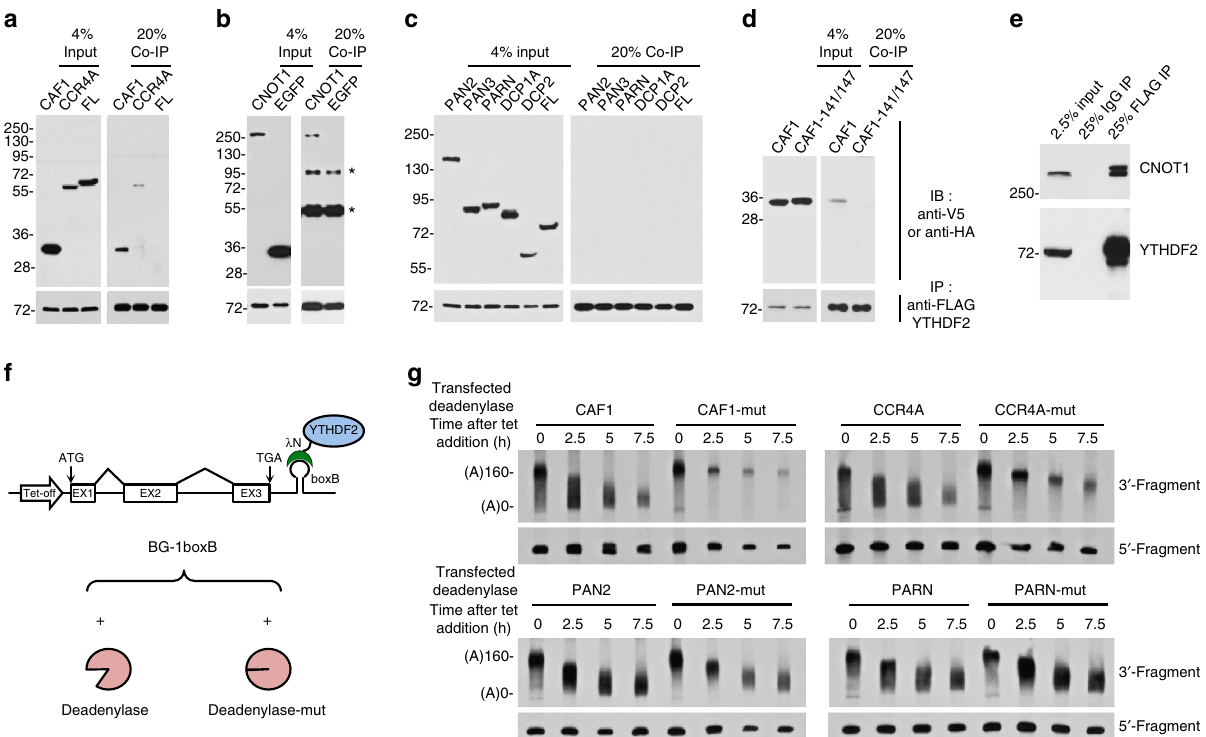
Figure 3 | The CCR4–NOTcomplex is responsible for YTHDF2-mediated RNA deadenylation. ( a – c ) Interaction between YTHDF2 and deadenylases or decapping enzymes. HEK 293 cells were co-transfected with a plasmid encoding FLAG-tagged YTHDF2 and either a V5-tagged CAF1, CCR4A, PAN2, PAN3, PARN, DCP1A, DCP2, FL or an HA-tagged CNOT1 or enhanced green fluorescent protein (EGFP). Lysates were subjected to immunoprecipitation by using anti-FLAG affinity gel. Input and co-purified proteins were blotted by probing with corresponding antibodies. Nonspecific bands were indicated by the asterisk. ( d ) Interaction between YTHDF2 and CAF1 or CAF1-141/147, a mutant version of CAF1 with M141K and L147K double substitution. ( e ) Interaction between stably expressed FLAG-tagged YTHDF2 and endogenous CNOT1 in HeLa-tTA cells. ( f ) Strategy of screening of functional deadenylases that are responsible for YTHDF2-mediated deadenylation. BG-1boxB reporter was co-transfected with l N-FLAG-YTHDF2 and either a wild-type or catalytically inactive deadenylase. ( g ) Deadenylation assay of BG-1boxB tethered by YTHDF2 with either a co-transfected wild-type or catalytically inactive